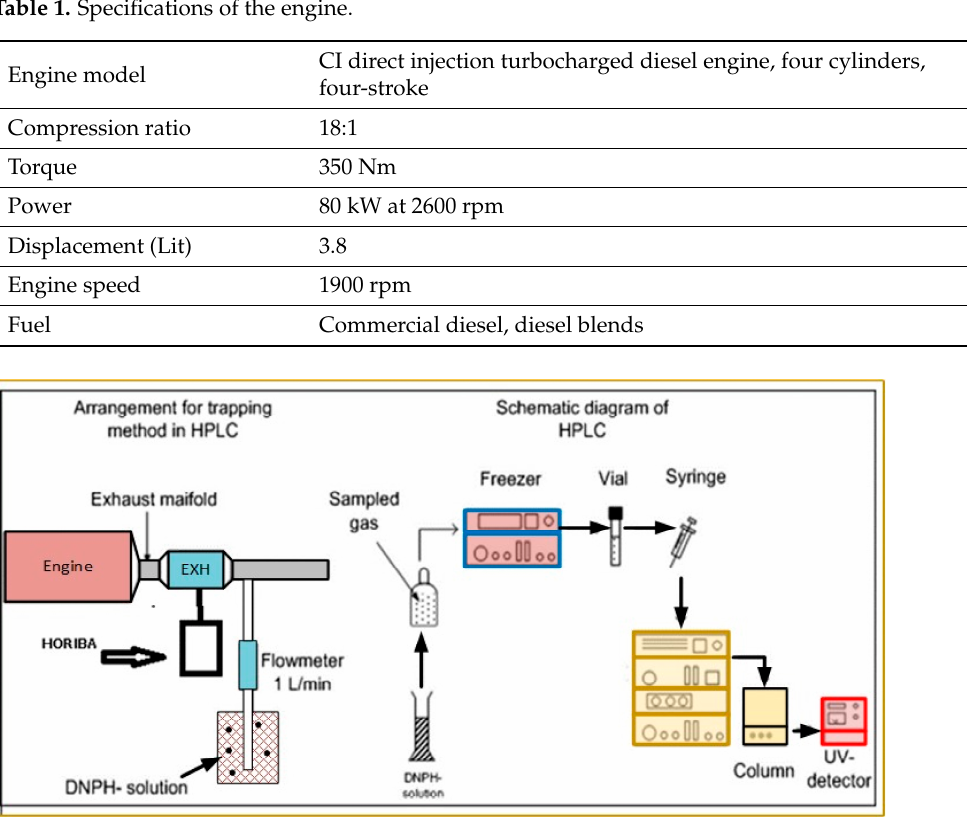
Figure 1. Experimental setup